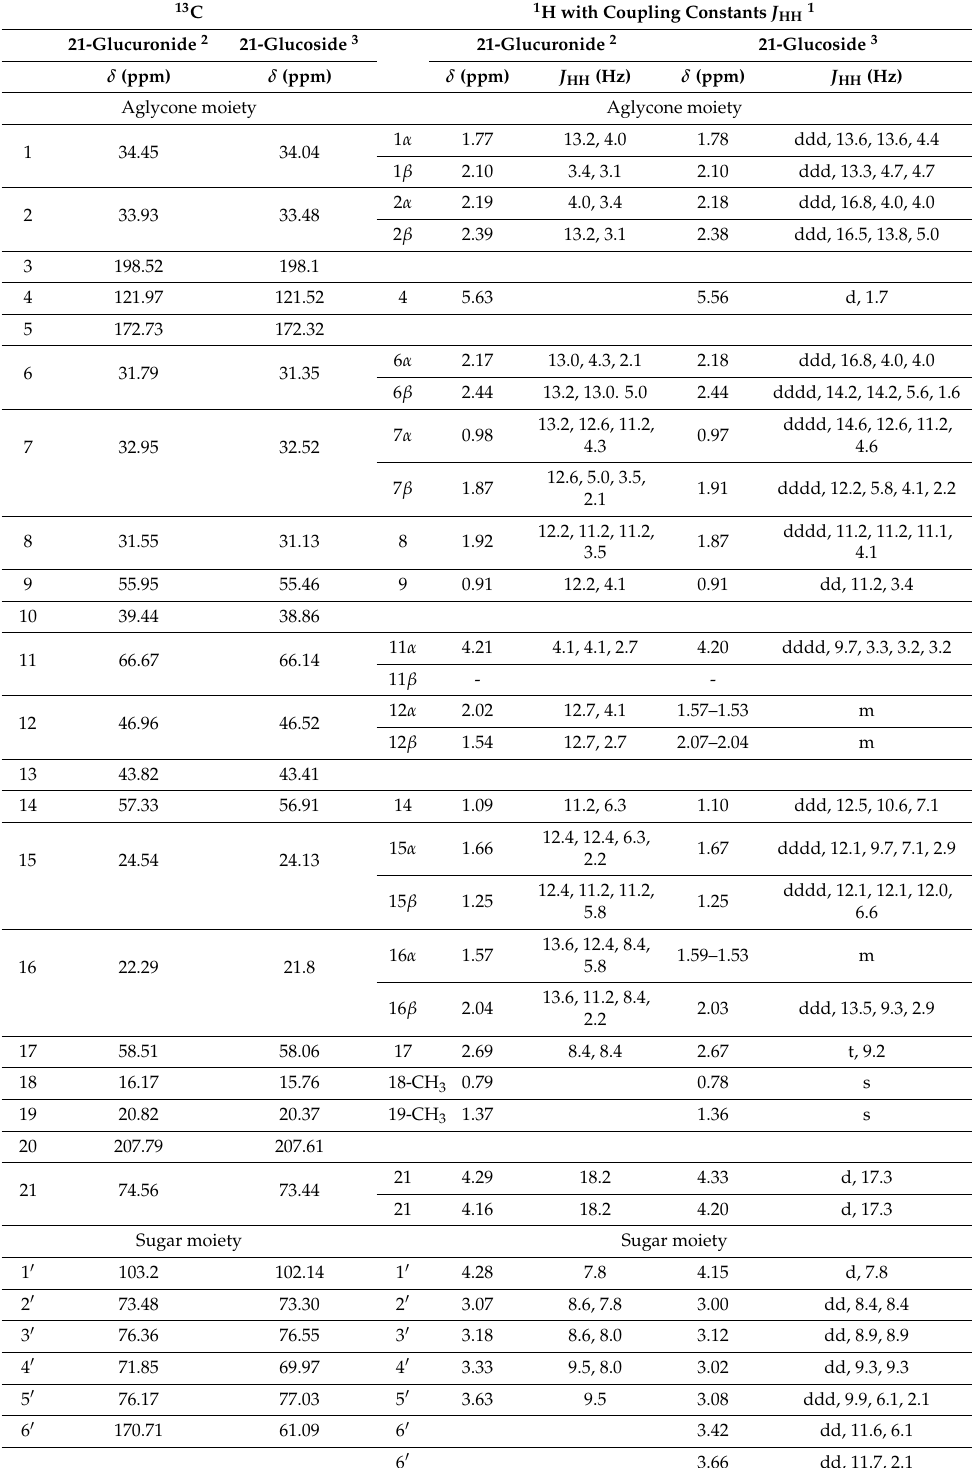
Table 1. Comparison of 13 C- and 1 H-NMR chemical shifts (ppm) and coupling constants (Hz) of corticosterone-21-glucuronide and